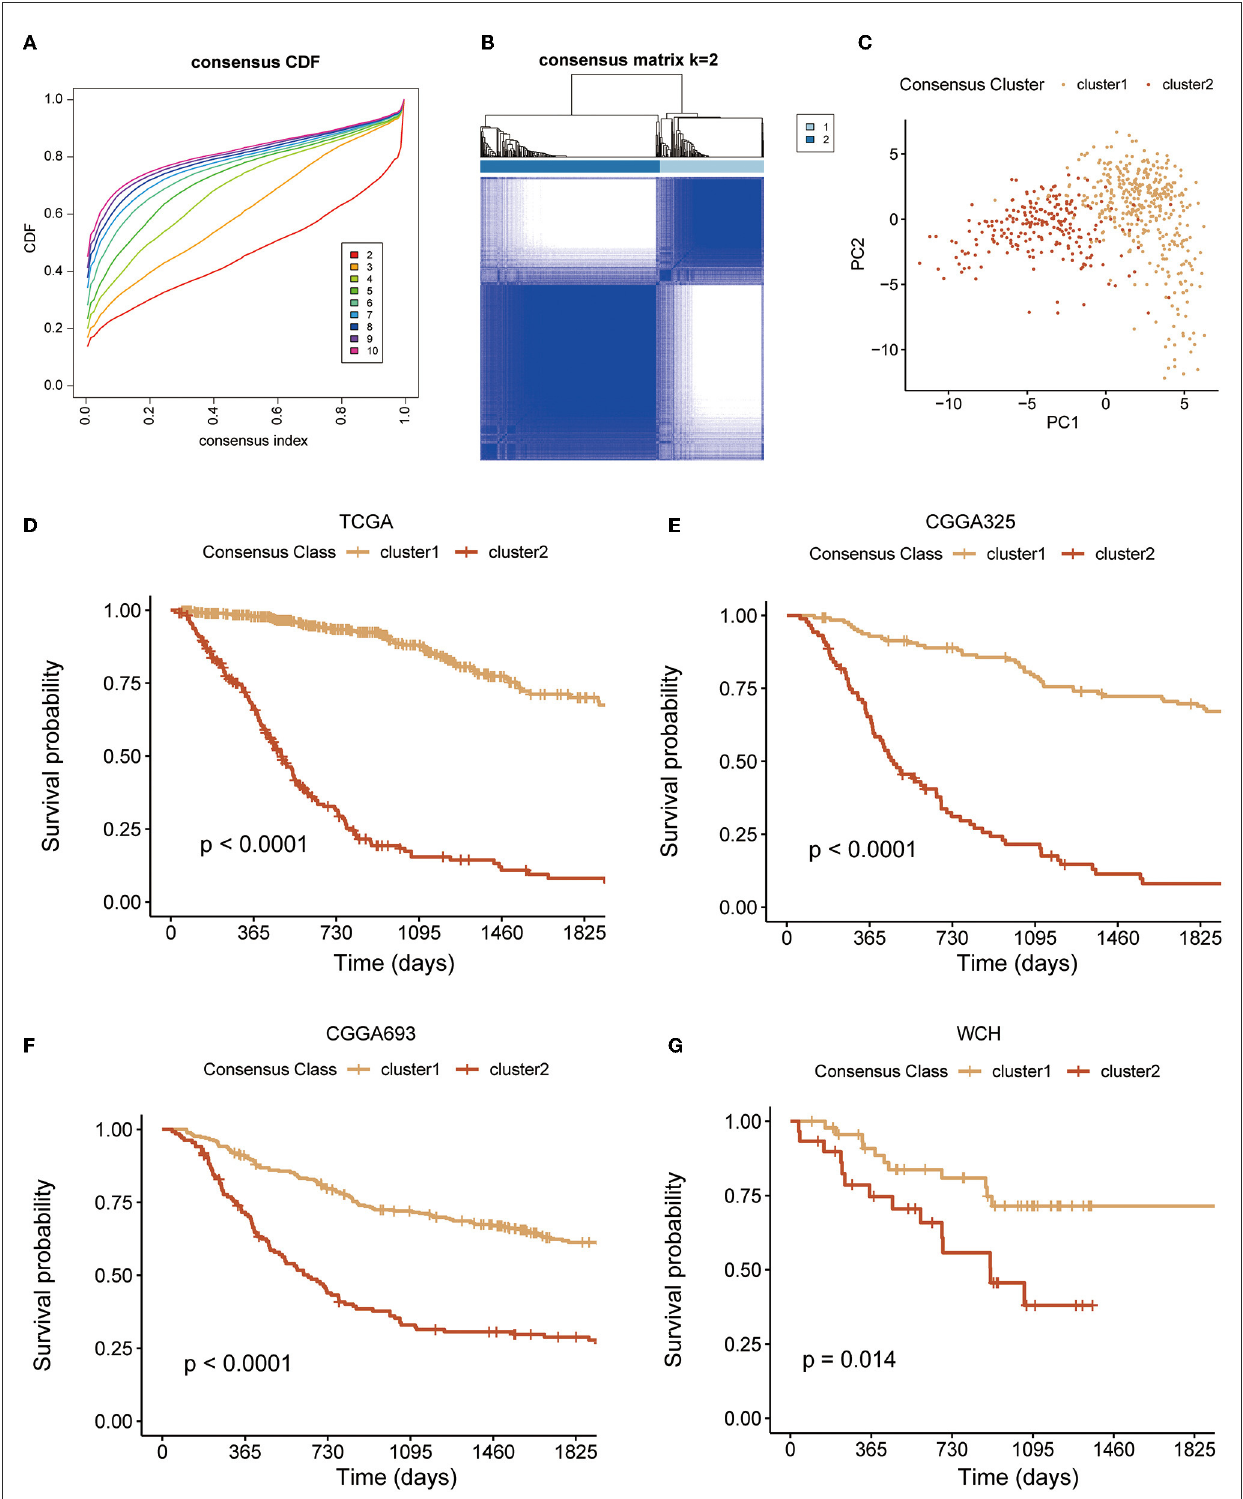
FIGURE1 Unsupervised cluster analysis. (A, B) The clustering implying the optimal κ was 2; (C) two distinct clusters formation under the PCA algorithm; and (D–G) K–M curves of clusters in four diffuse glioma cohorts. PCA, principal component analysis; K–M,